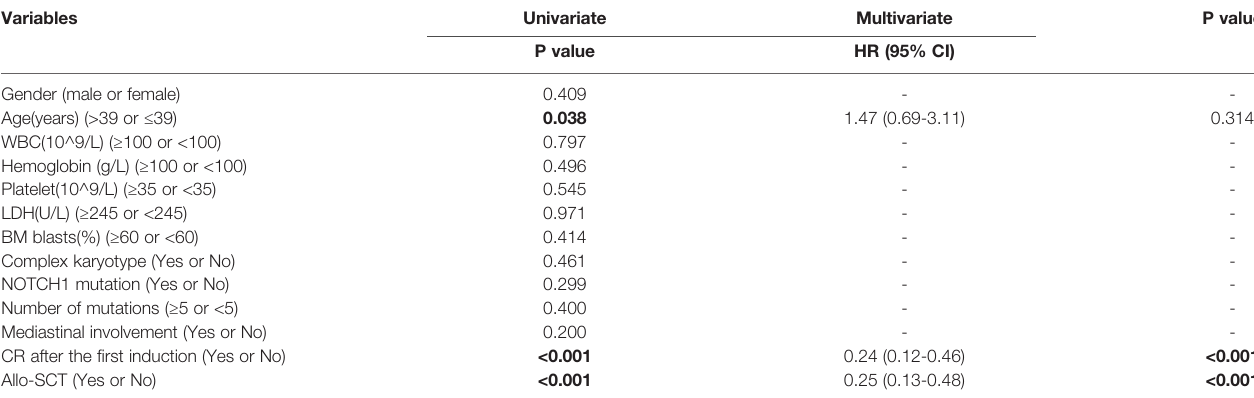
TABLE 2 | Univariate and multivariate Analyses of overall survival (OS) for early T-cell precursor acute lymphoblastic leukemia/lymphoma (ETP-ALL/LBL). Variables